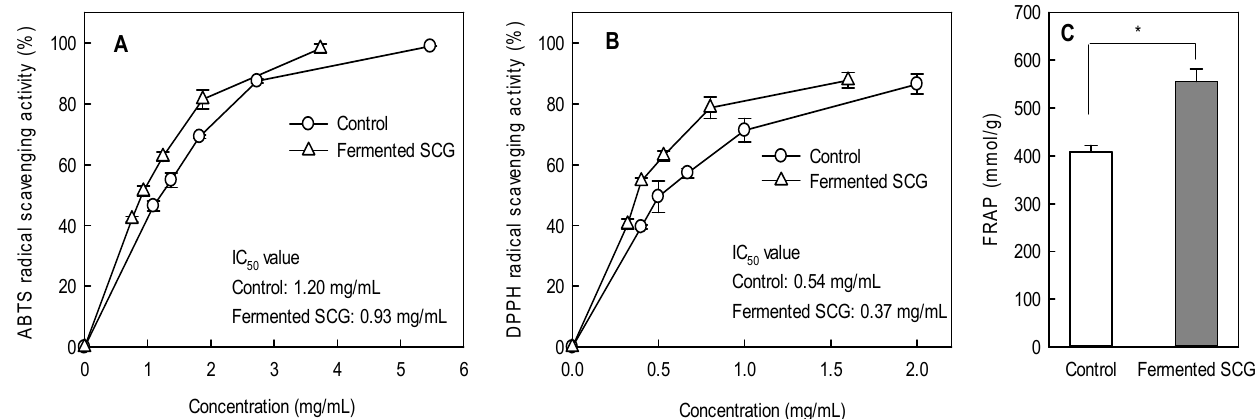
Figure 2. ABTS ( A ) and DPPH ( B ) radical scavenging activity and FRAP ( C ) levels of SCG after 8 days of fermentation. Values are the means ± SD ( n = 3). The differences between the unfermented (control) and fermented SCG were evaluated using Student’s t -test (* p < 0.05). The half-maximal inhibitory concentration (IC 50 ) is the effective concentration at which 50% of the ABTS or DPPH radical is scavenged.